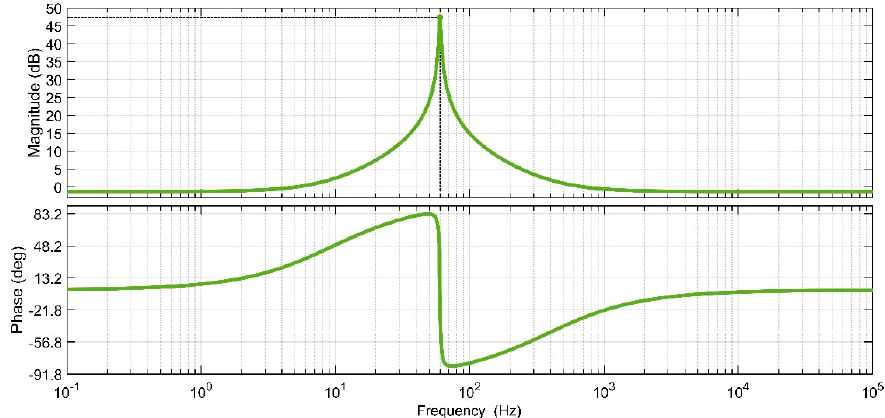
Figure 10. PR controller magnitude response and phase response controller.